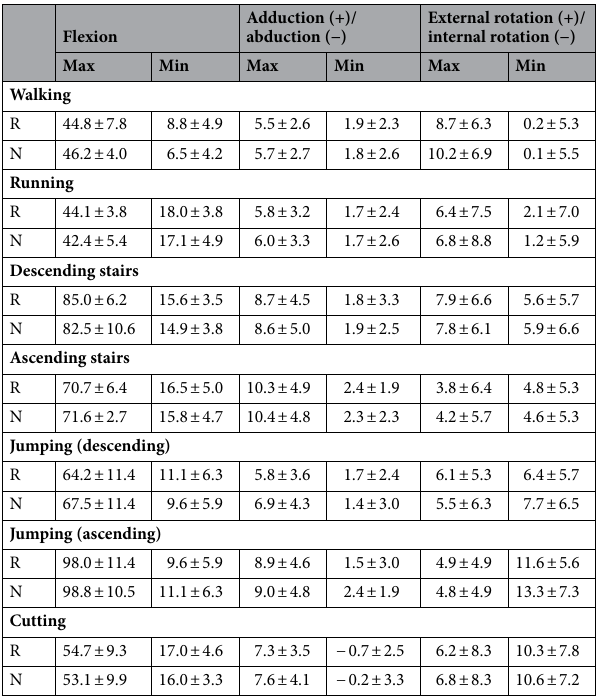
Table 2. Extreme knee joint angles (°) in three motion planes during six functional movements (mean ± standard deviation). N normal shoes, R rocker-soled shoes. a Represents an angle for rocker-soled shoes that is significantly larger than for normal shoes ( p < 0.007). b Represents an angle for normal shoes that is significantly larger than for rocker-soled shoes ( p <